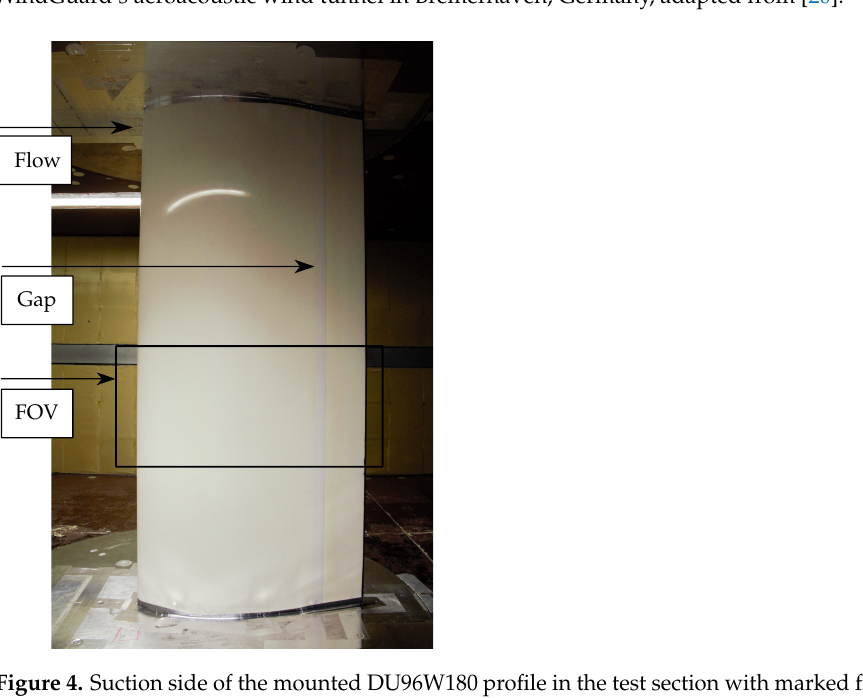
Figure 4. Suction side of the mounted DU96W180 profile in the test section with marked field of view (FOV) of the thermographic